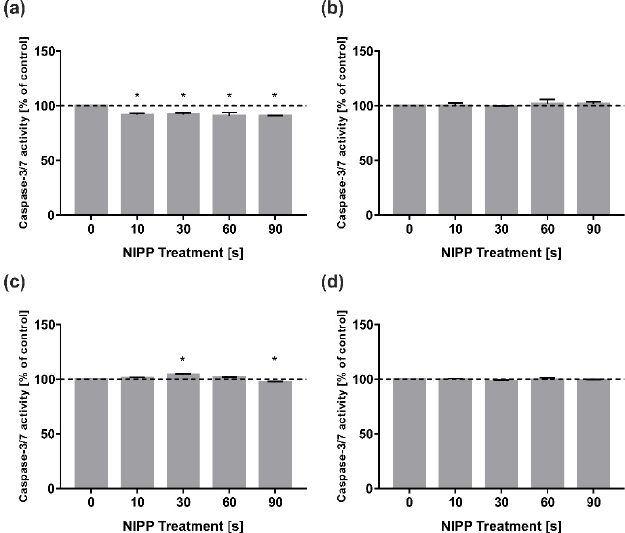
Figure 6. Effects of NIPP on Caspase-3/7 activity in HGF and HGK 24 h and 48 h after treatment, respectively. Data was normalised to control. Treatment was performed for the indicated times: ( a ) Caspase-3/7 activity in HGF at 24 h; ( b ) Caspase-3/7 activity in HGF at 48 h; ( c ) Caspase-3/7 activity in HGK at 24 h; ( d ) Caspase-3/7 activity in HGK at 48 h. n = 6. * statistical significance compared to control (0 s) ( p < 0.05).